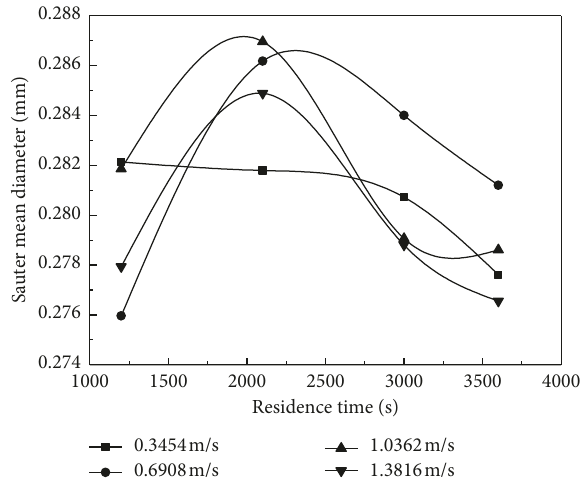
Figure 11: The influence of circulation flow rates on the Sauter mean size.